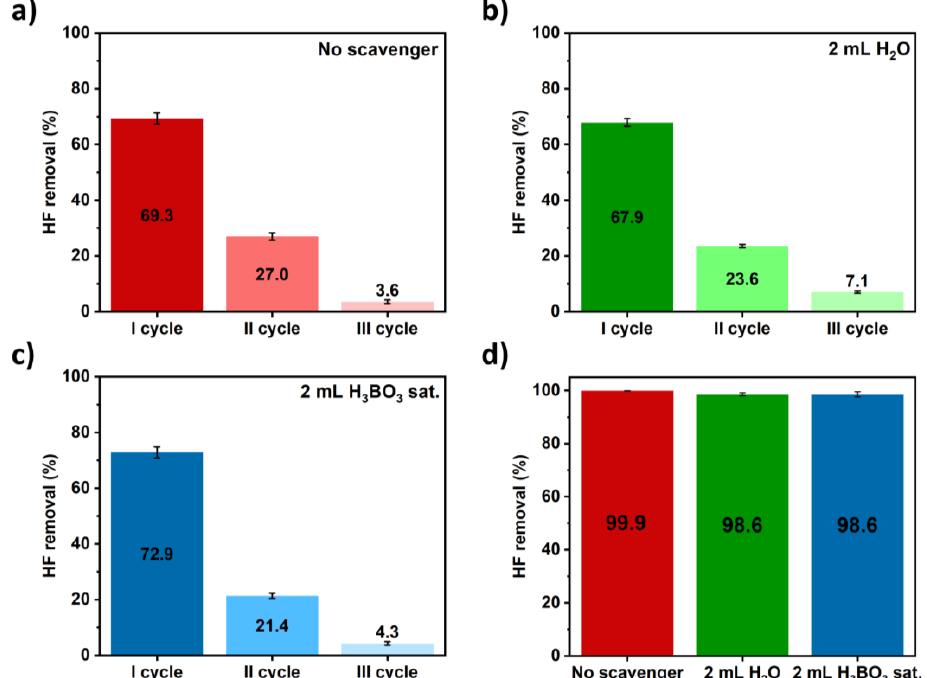
Figure 3. Comparison of HF removal efficiencies obtained using different experimental conditions outside the PFA vessel. ( a – c ) HF removal after each cycle using ( a ) no scavenger, ( b ) H 2 O and ( c ) H 3 BO 3 as scavenging solutions. ( d ) A comparison of total HF removal and the entire MW protocol (three cycles).